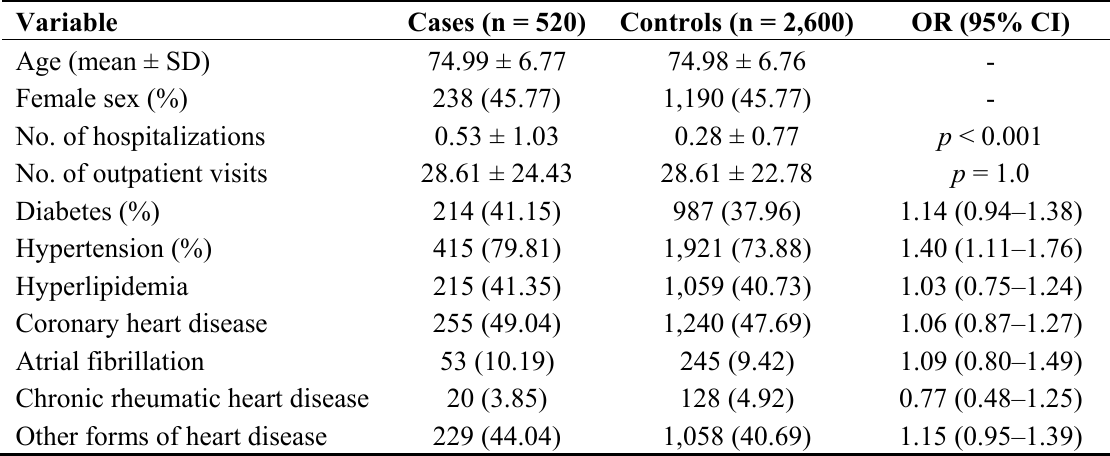
Table 1. Demographic characteristics of stroke cases and